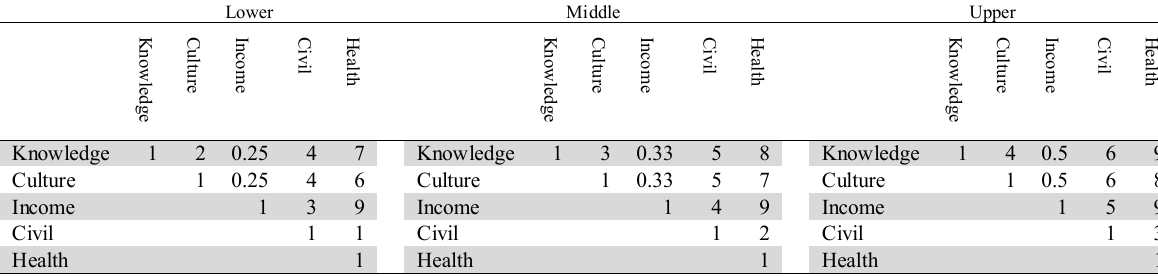
The summary of lower, middle and upper